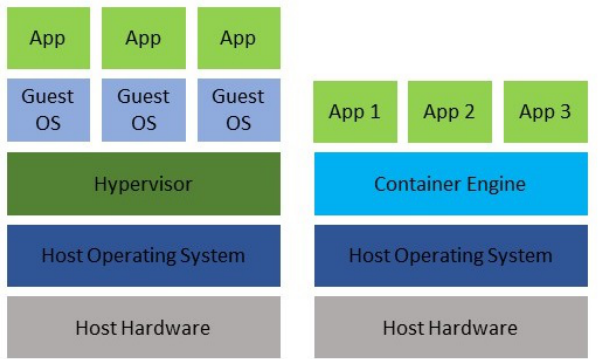
Figure 3. Full System Virtualisation and Container